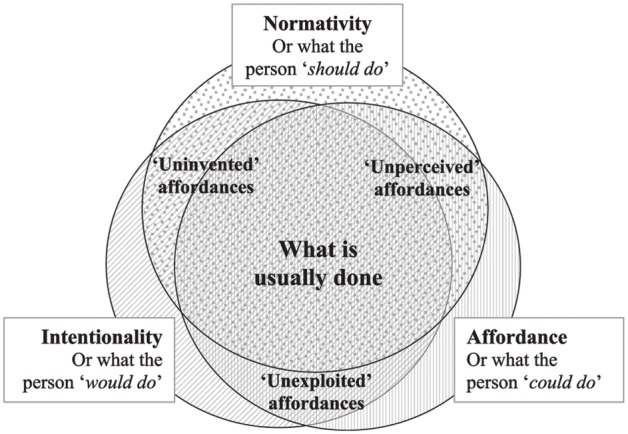
A sociocultural model for an affordance theory of creativity (Glăvenau, 2012, p. 197).